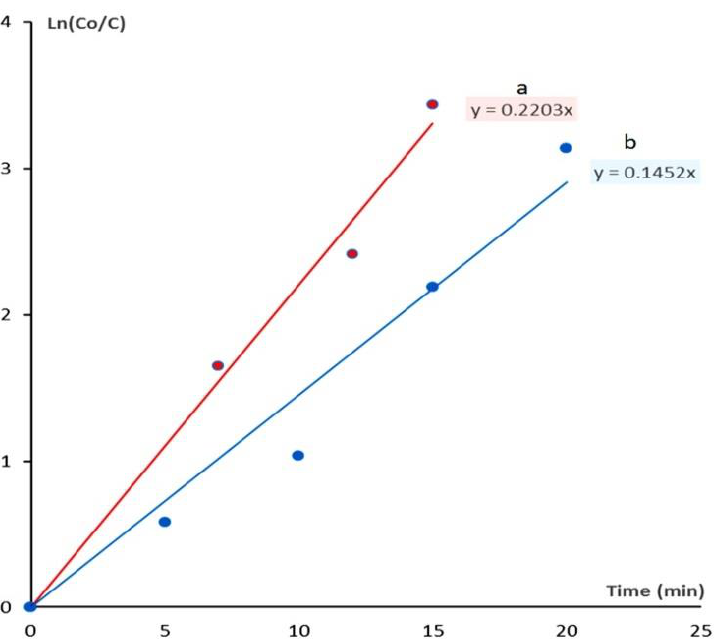
Figure 14. Kinetics study of the photocatalytic degradation of Naphthol green B in presence of: ( a ) NHZ-1-500 and ( b ) NHZ-2-500.